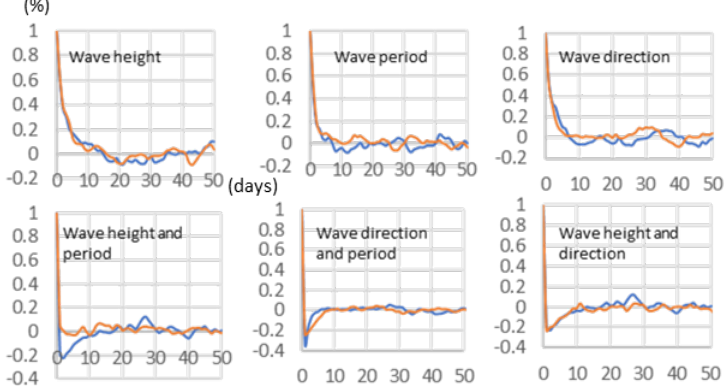
Figure 12. In the time period from: 1 April 2013 to 30 June 2016, first row: autocorrelation up to 50 lags for each sea condition variable. Second row: cross-correlation between pairs of sea condition variables. Blue lines are the auto/cross correlation function of the original data, and the red lines correspond to those of the simulated data. Note: In all plots the horizontal axis is the lag time in days and the vertical axis is the normalised correlation value which lies between 1 and − 1.